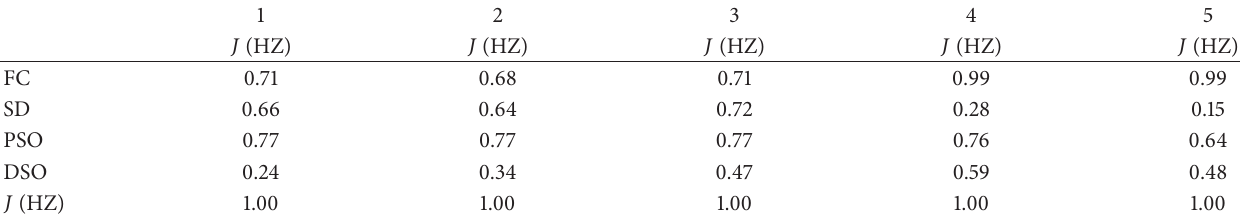
Table 3: Correlation of computed Ramsey terms to the spin-spin coupling over all atoms in each of the